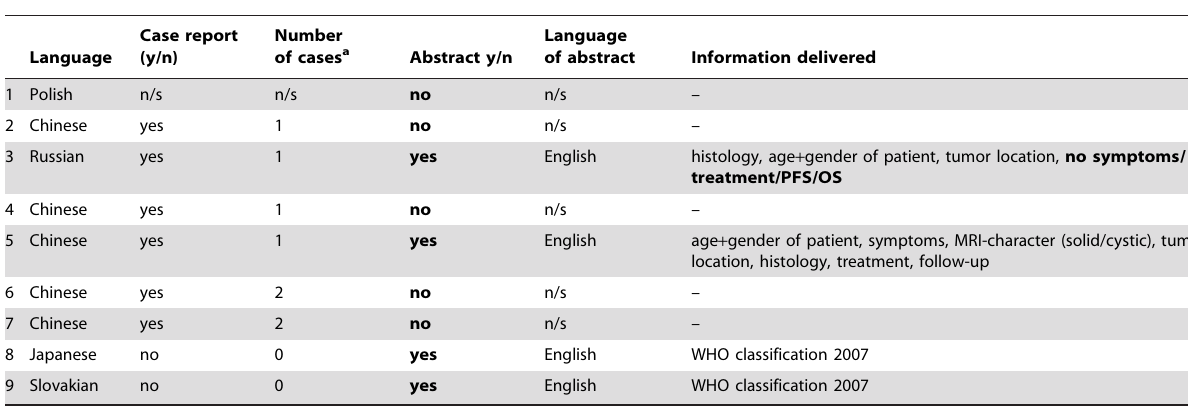
Table 1. Limitation of this study - non-English articles.